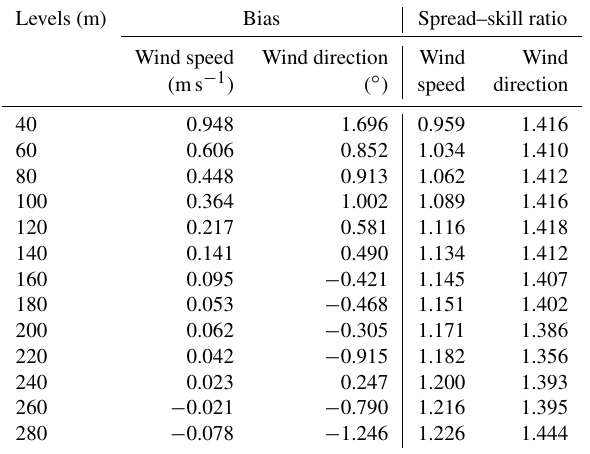
Table 3. The AROME-EPS ensemble bias and spread–skill ratio averaged over forecast range in the vertical levels observed by lidar located in the PTILH